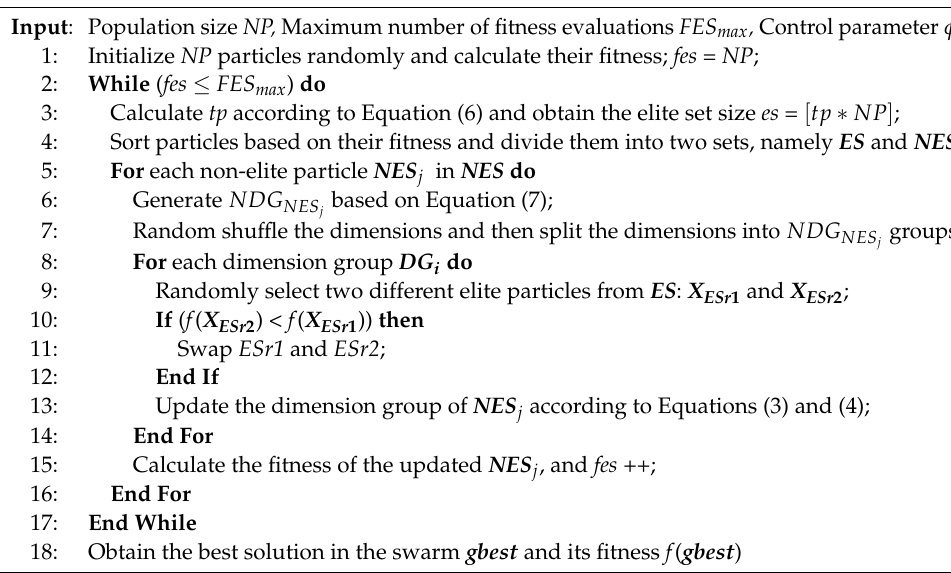
Algorithm 1: The Pseudocode of